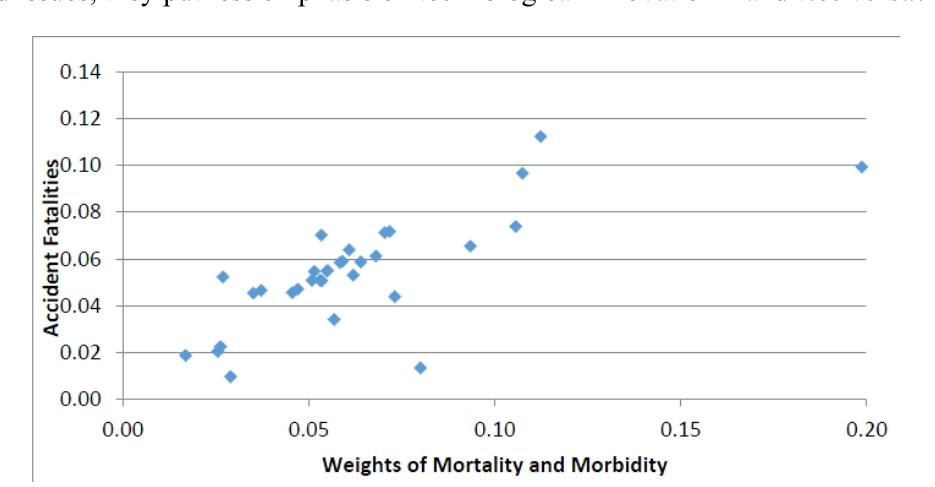
Figure 7. Relationship of weights of “morbidity and mortality” and “accident